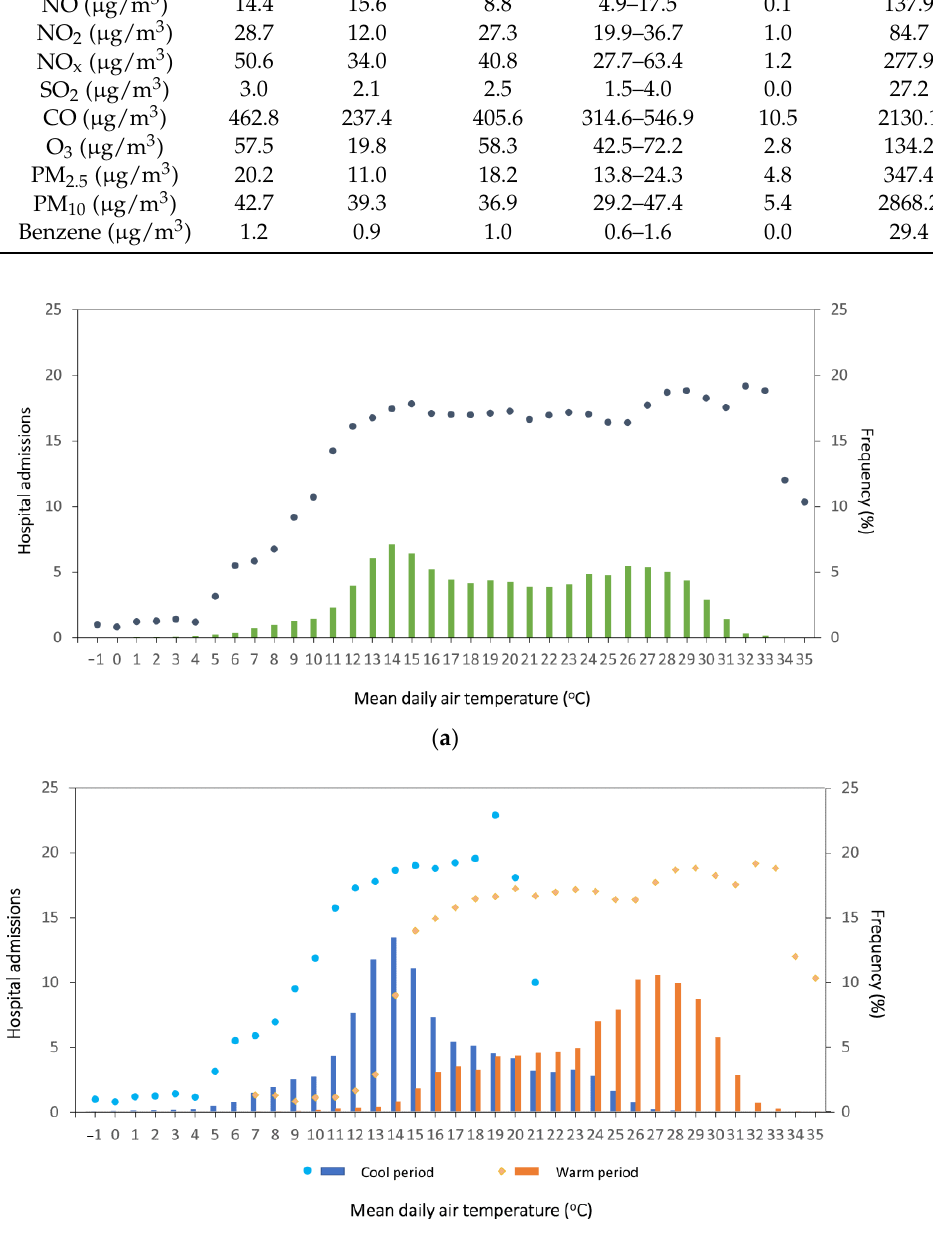
Figure 3. Mean hospital admissions per 100,000 population (dots and diamonds) in 1 ◦ C intervals of air temperature in Cyprus (2009–2018) and frequency of mean daily air temperature (bars) ( a ) overall and ( b ) by cool and warm